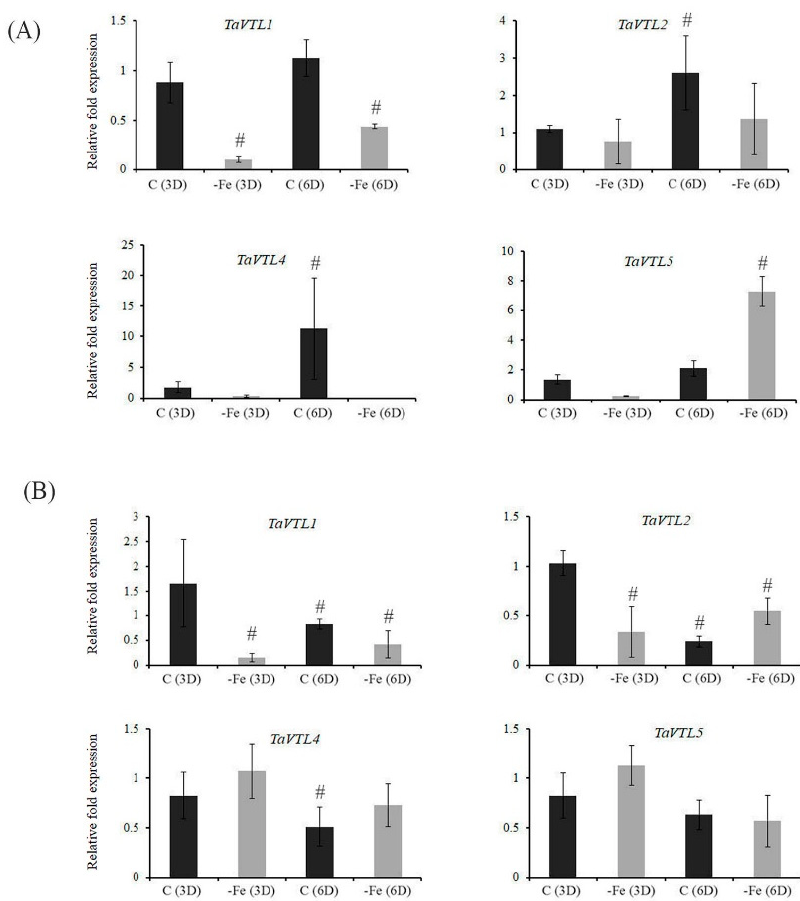
Figure 4. Tissue-specific qRT-PCR expression analysis of wheat VTL genes during Fe deficiency (-Fe) and in the control (C) conditions. Wheat seedlings were subjected to Fe deficiency for three and six days represented as -Fe(3D) and -Fe(6D). The controls for the respective time points are represented as C(3D) and C(6D). ( A ) Fold expression analysis was performed in roots and ( B ) in shoots. 2 µ g of total RNA for the cDNA preparation. Relative fold expression levels were calculated relative to C(3D). C t values were normalized using wheat ARF1 as an internal control. Vertical bars represent the standard deviation. # represents the significant difference at p < 0.05 with respect to their respective control treatments.